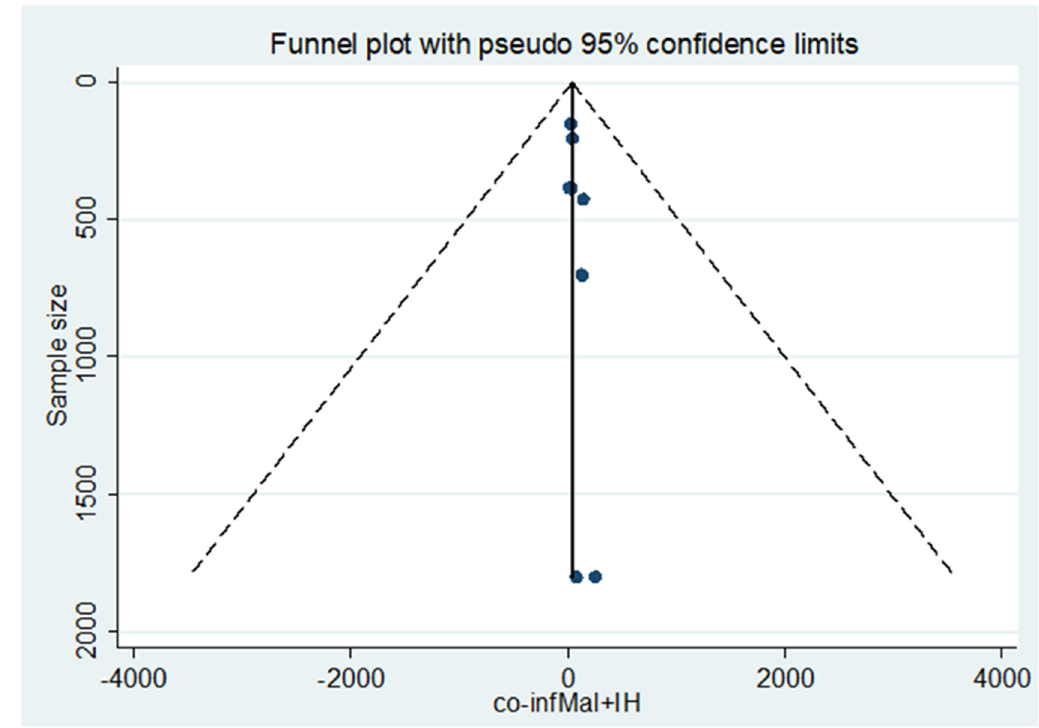
Figure 3. Funnel plot with 95% confidence limit of the comorbidity of geo ‐ helminths and malaria among the outpatients in Ethiopia, 2020.